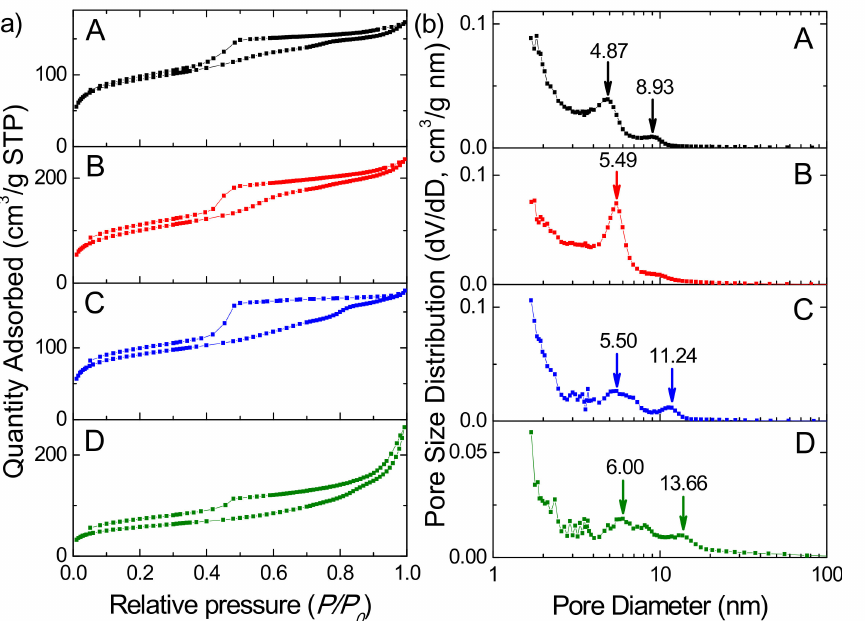
Figure 9. ( a ) Nitrogen adsorption-desorption isotherms and ( b ) pore size distribution of mesoporous organosilica samples: PMOBH-1 (A), PMOBH-2 (B), PMOBH-3 (C), PMOBH-4 (D).